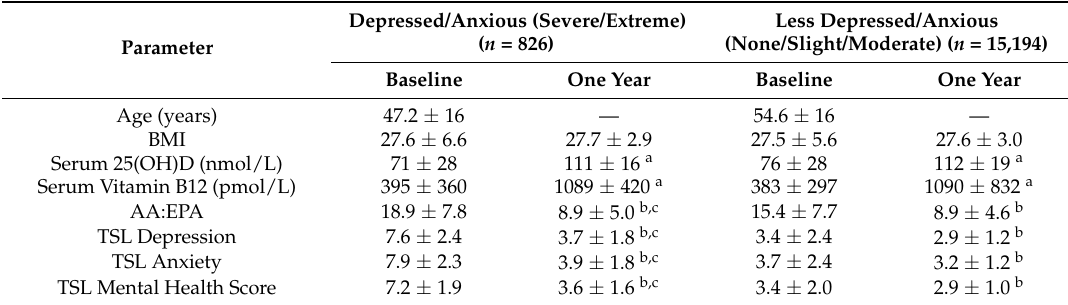
Table 6. Comparison of biomarkers of nutrition with levels of depression and anxiety. Depressed/Anxious (Severe/Extreme) Less Depressed/Anxious ( n = 826) (None/Slight/Moderate) ( n = 15,194) Parameter Baseline One Year Baseline One Year Age (years) 47.2 ± 16 — 54.6 ±